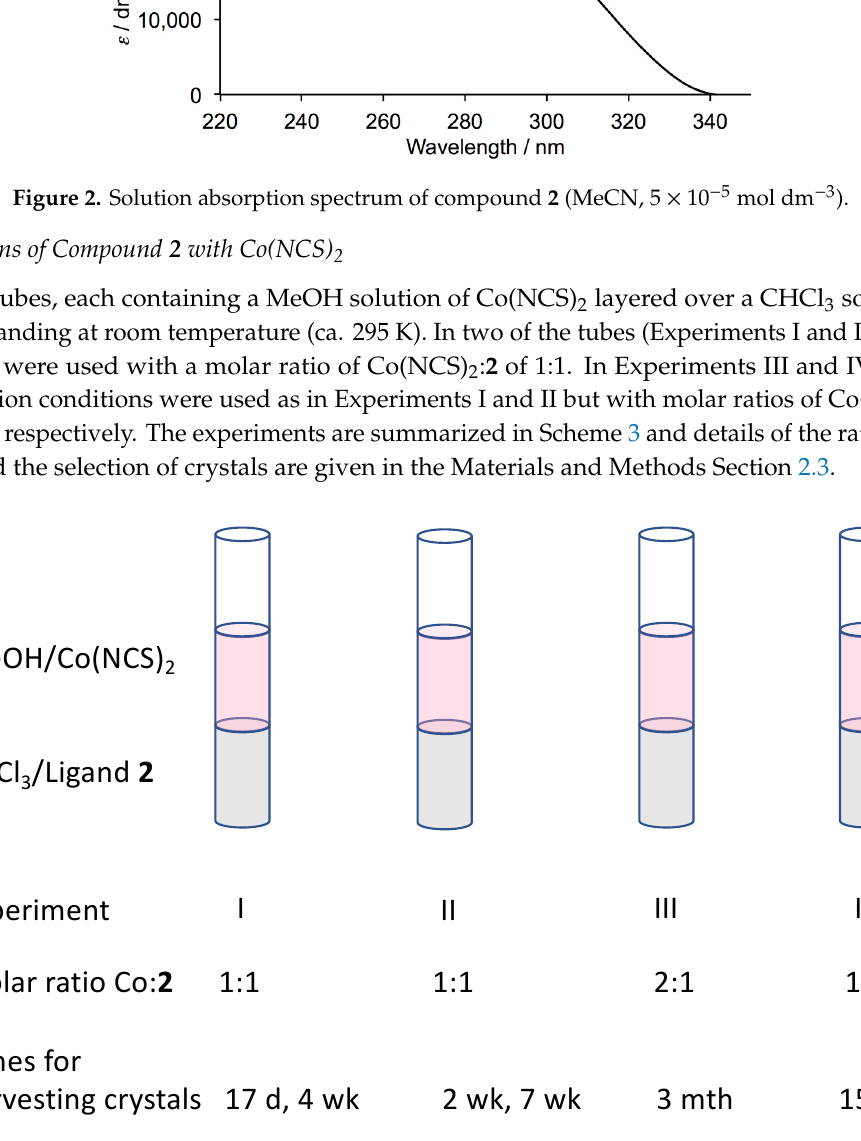
Figure 2. Solution absorption spectrum of compound 2 (MeCN, 5 × 10 –5 mol dm –3 ).